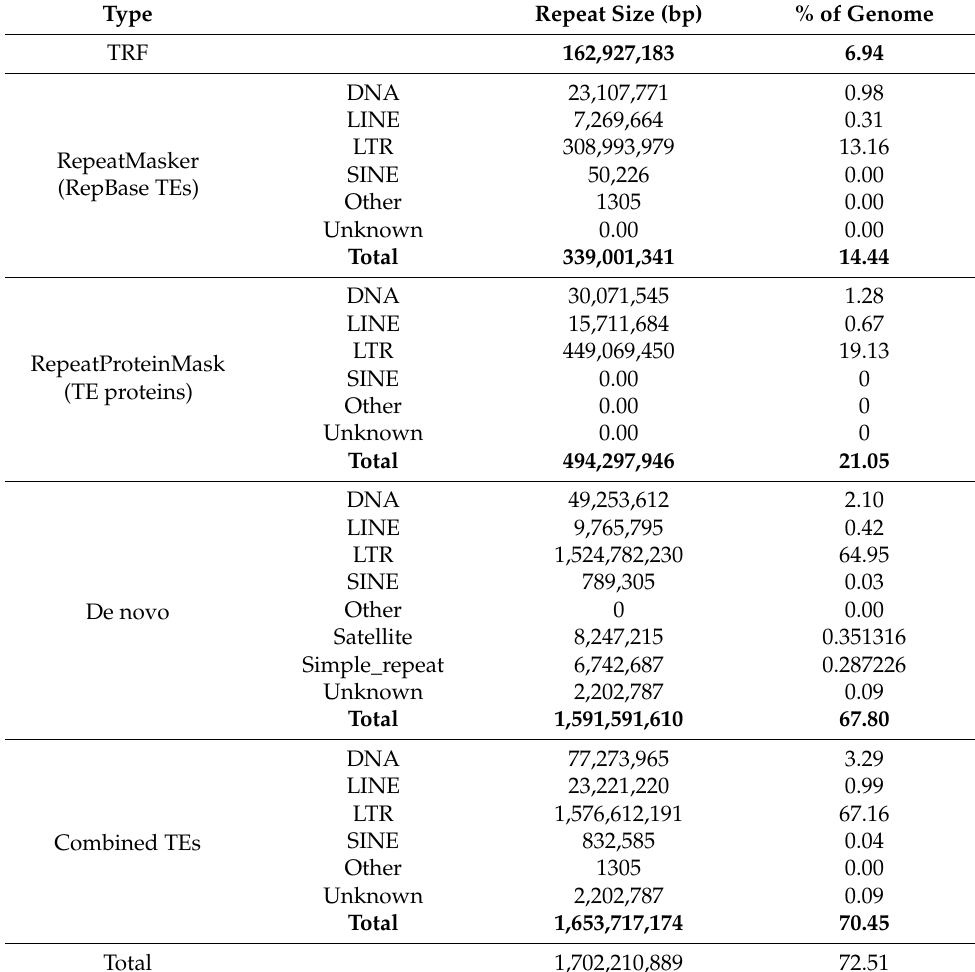
Table 4. TEs Content in the assembled B. rotunda